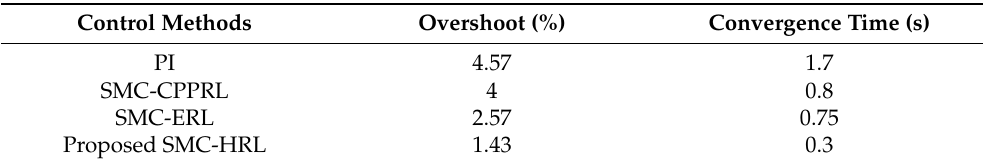
Table 3. Comparison analysis of DC-link voltage performance during the system startup condition from the experimental